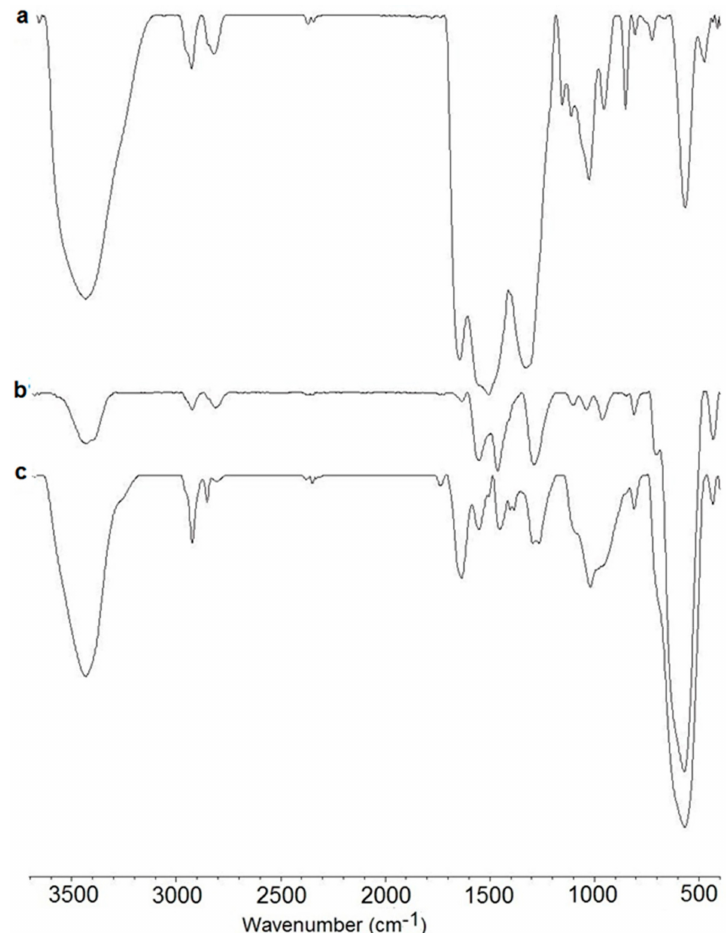
Figure 2. Fourier transformed infrared (FTIR) spectra of (CeNP) covered with PEI crosslinked (CePEI-GA) ( a ), MNP Covered with polyethylenimine (PEI) (MPEI) ( b ) and MCePEI-GA ( c